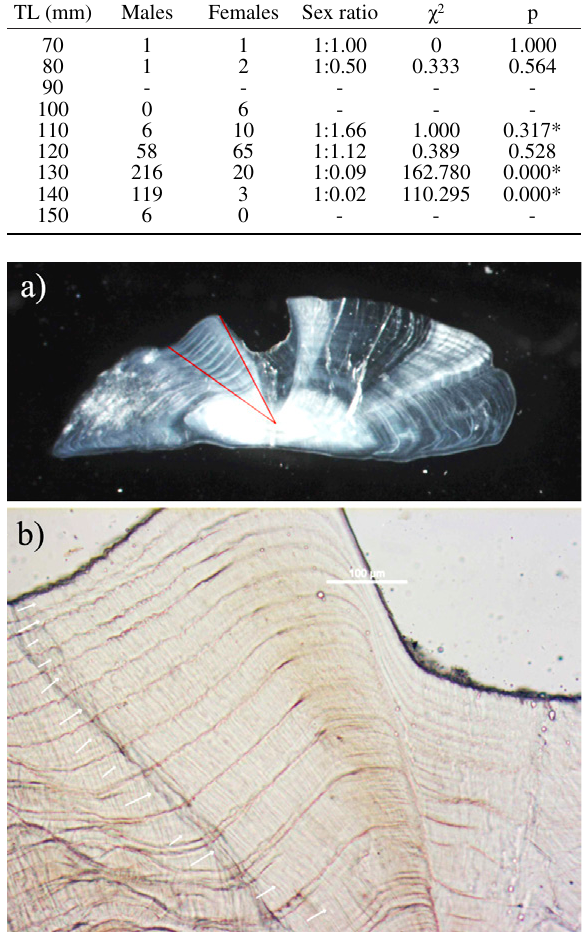
Fig. 2. – Otolith transverse sections showing the selected zone for ageing and the nucleus (a, 40× under reflected light) and annual rings for an individual of 13 years (b, 100× under transmitted light).